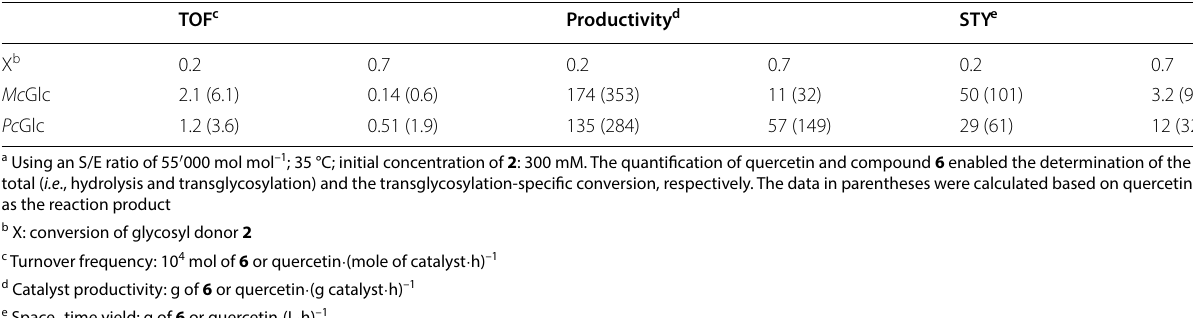
Table 5 Performance of Mc Glc and Pc Glc in optimized transglycosylation reactions at low and high conversions with 2 in suspension in the presence of 2-phenylethanol